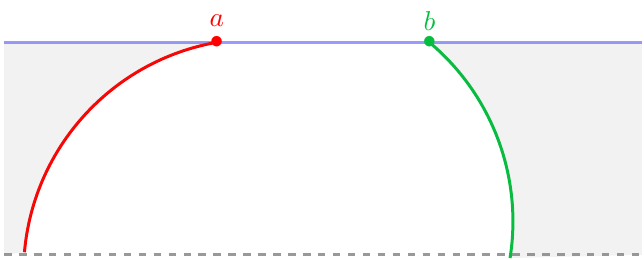
Figure 8 . A typical brane configuration on a constant time t = t 0 slice in the presence of a bulk BTZ black hole. Both branes have positive tension and are embedded according to eq. (4.37). The shaded regions are removed and the dashed black line is the planar black hole horizon. We neglect the parts of the branes behind the black hole horizon which are easily seen to be